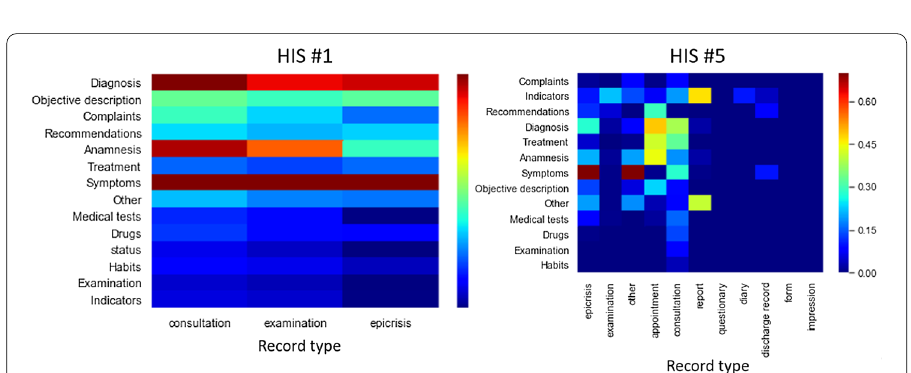
Fig. 12 Distribution of subsections among record types for two selected